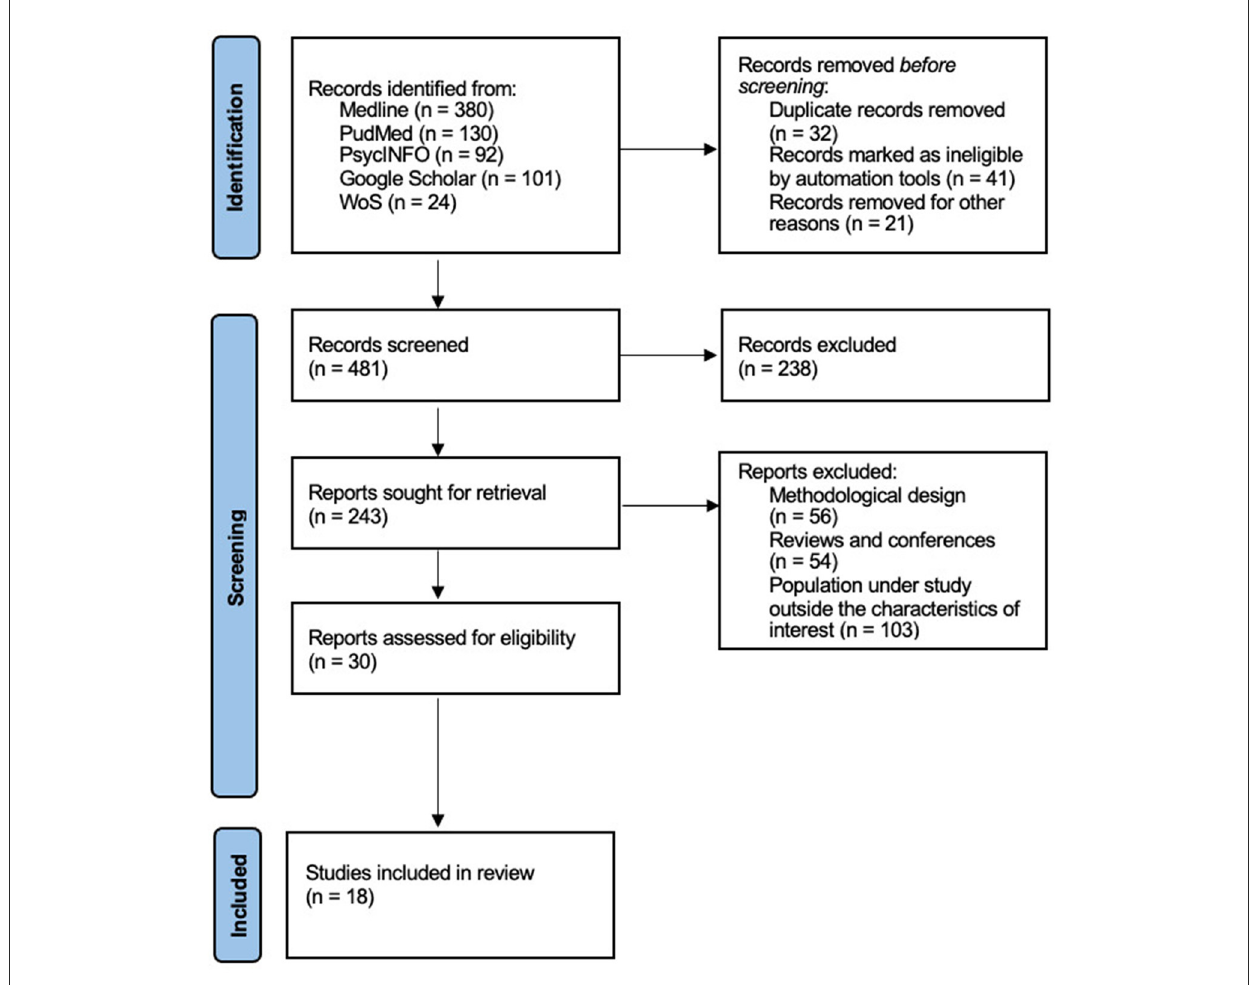
FIGURE1 Flow chart of study selection.